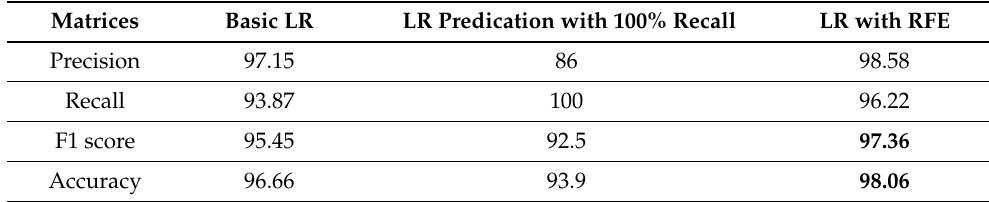
Figure 6. Comparisons of the learning curve of training and cross-validation scores for ( a ) simple LR and ( b ) LR with RFE. Table 4. Logistic regression performance with basic LR, LR predication with 100% recall, and LR with RFE under